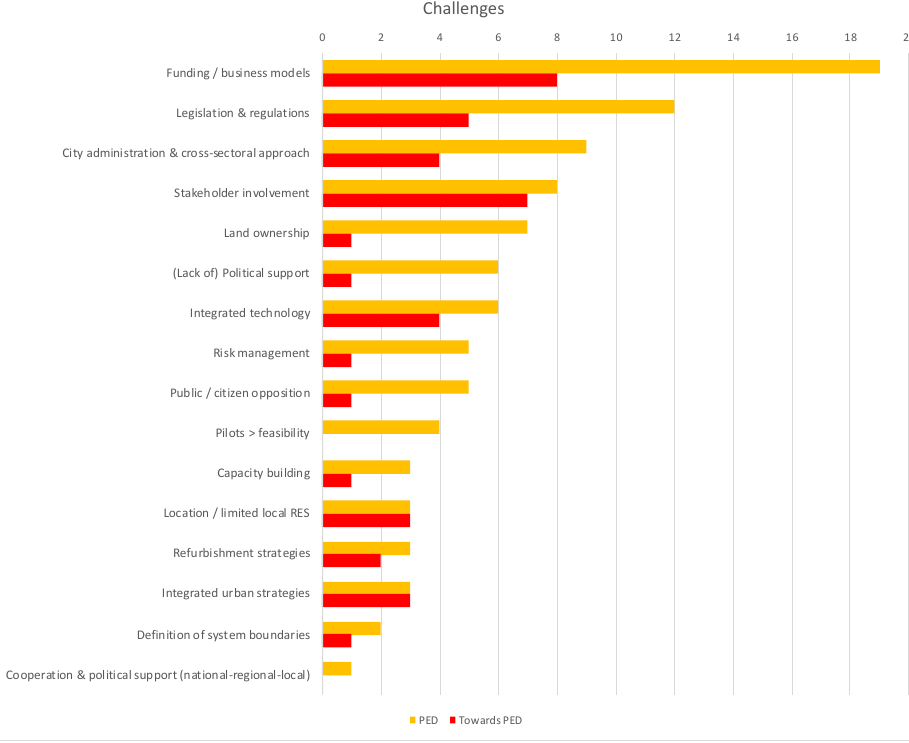
Figure 6. Challenges and barriers for implementation of PED and To-PED projects.